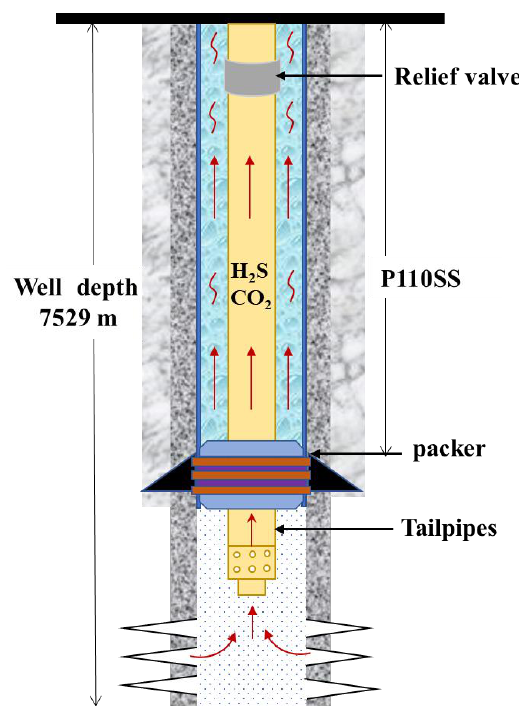
Figure 1. Schematic diagram of production well of HTHP acid gas well.